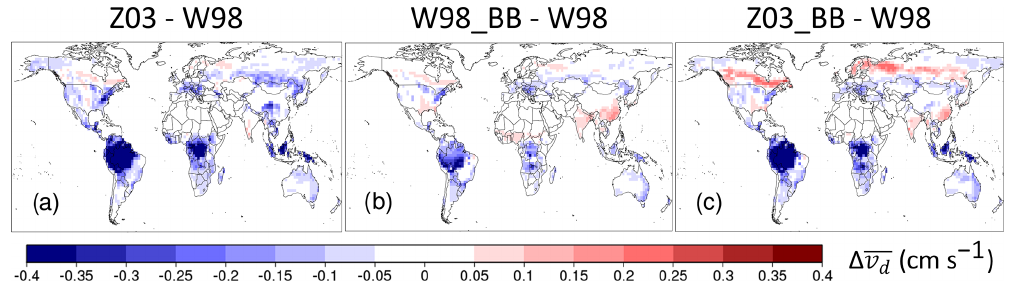
Figure 3. Differences of 1982–2011 July mean daytime v d ( (cid:49)v d ) between three other parameterizations (Z03, W98_BB, and Z03_BB) and W98 over vegetated land